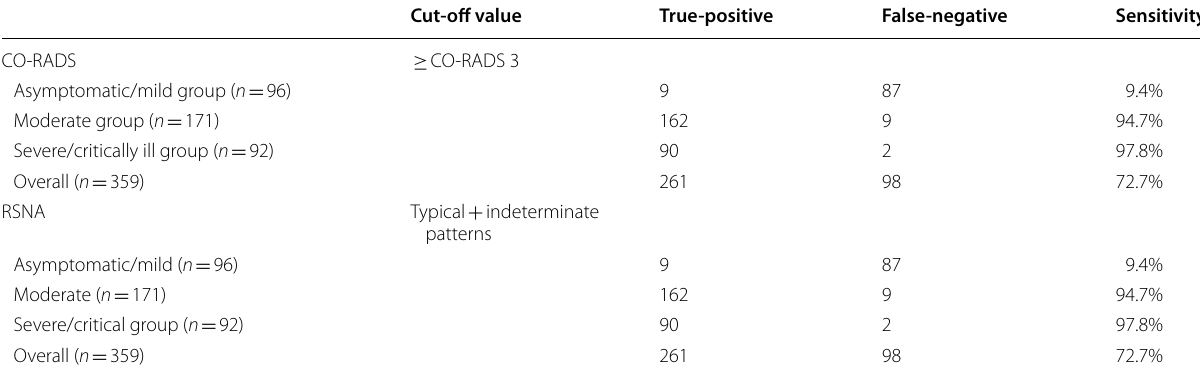
Table 5 Sensitivity of CO‑RADS and the RSNA chest CT classification system in the diagnosis of COVID‑19 patients stratified by clinical group